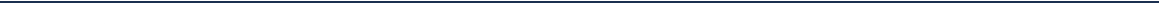
Keywords: Orofacial pain, Headache, Migraine, Tension-type headache